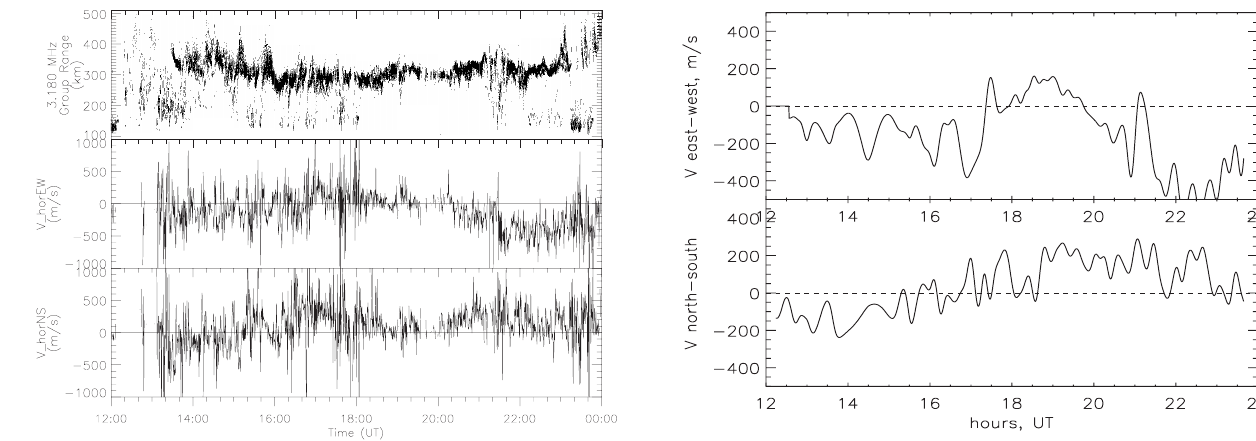
Figure 3. Data from 17 Feb. 1996. The panels show the lowpass filtered velocity components. Noon MLT is 20 UT. Fig. 3. Data from 17 February 1996. The panels show the lowpass filtered velocity components. Noon MLT is 20:00 14